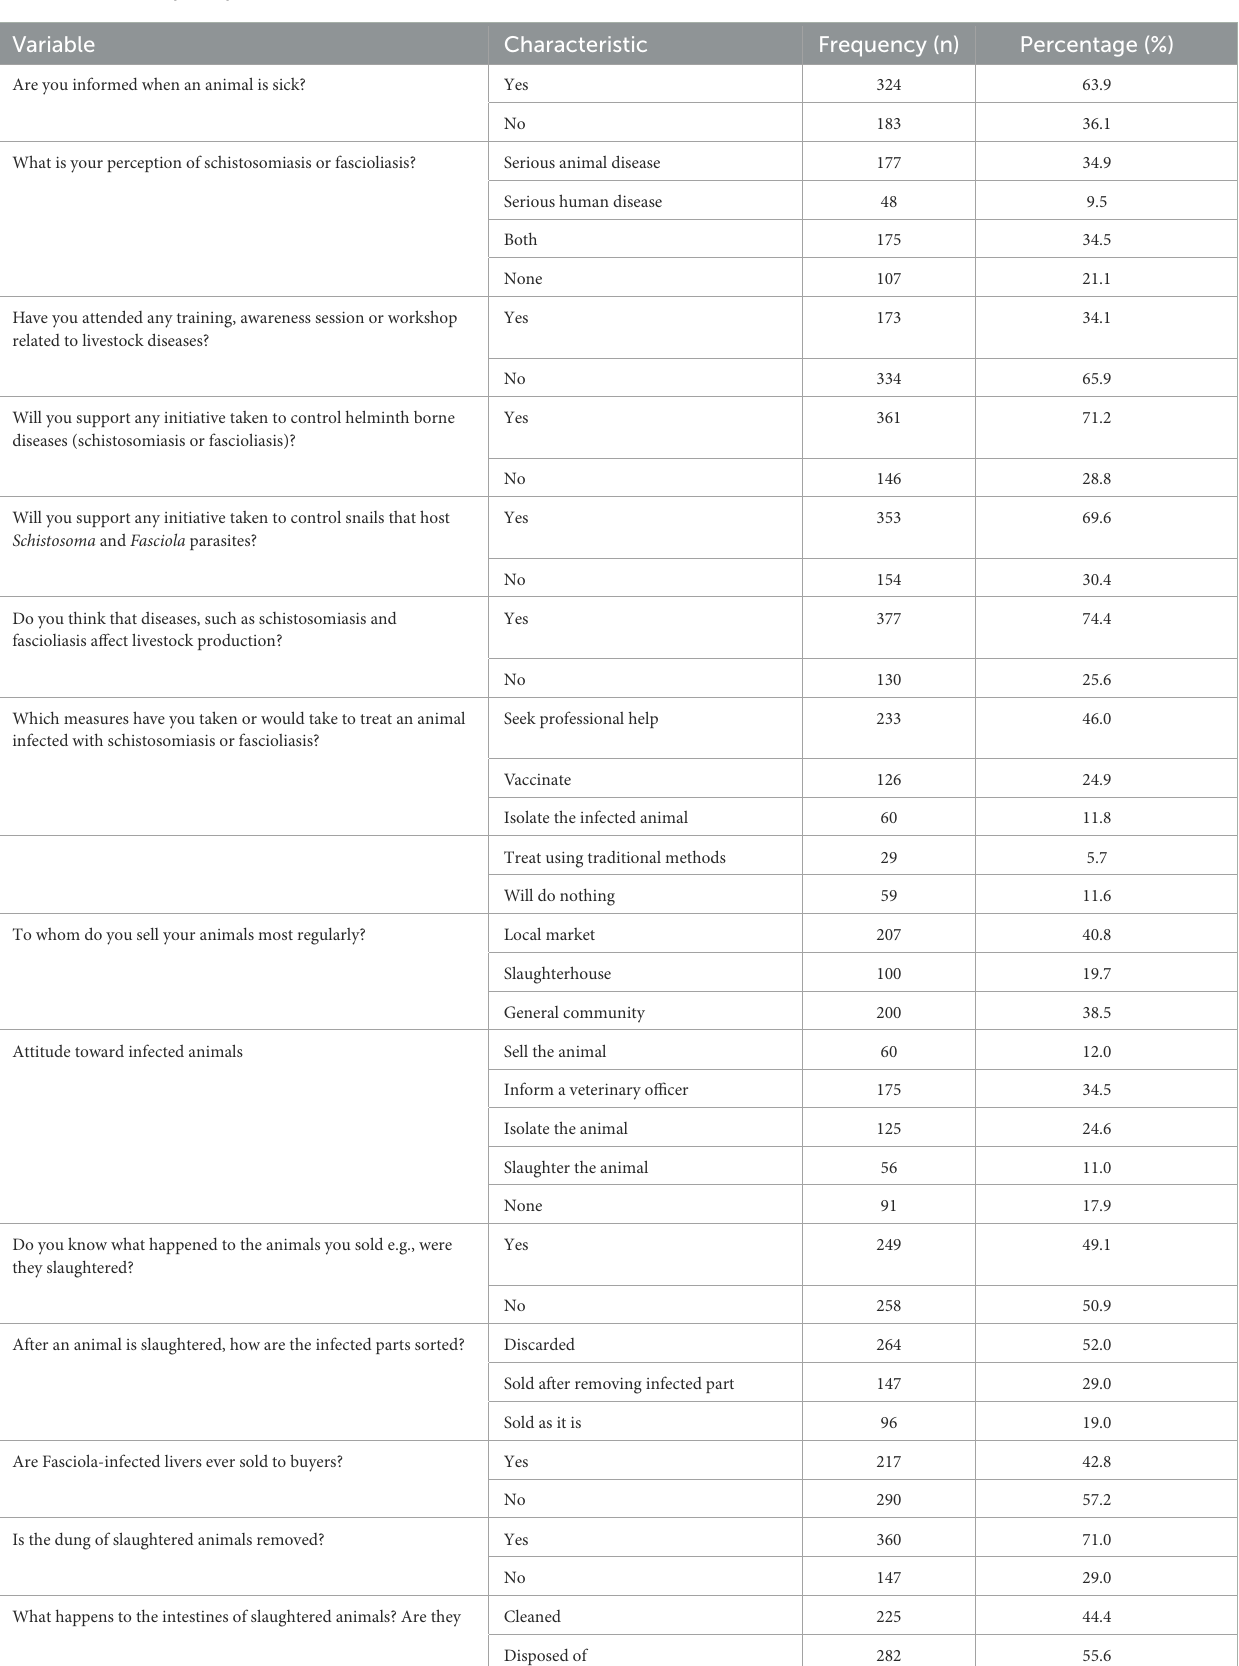
TABLE 4 Attitudes of participants toward schistosomiasis and